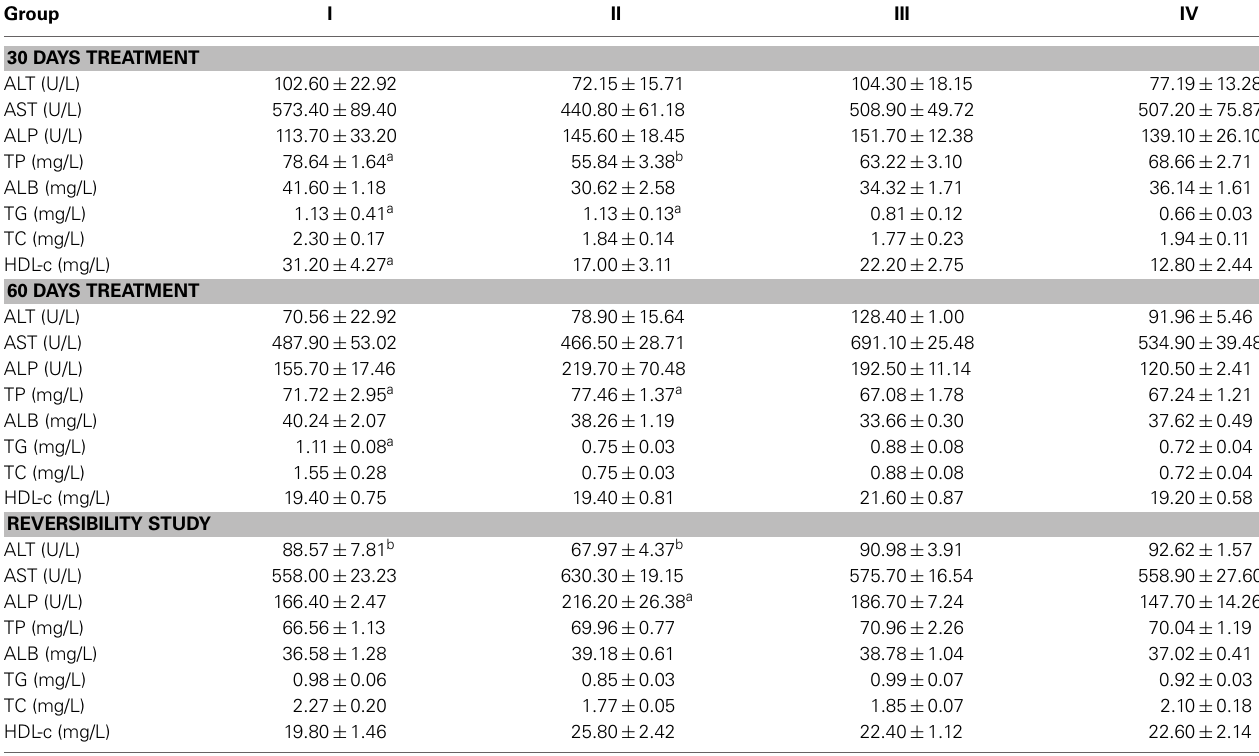
a and b represent significant increase and decrease at p < 0.05 compared to control values,